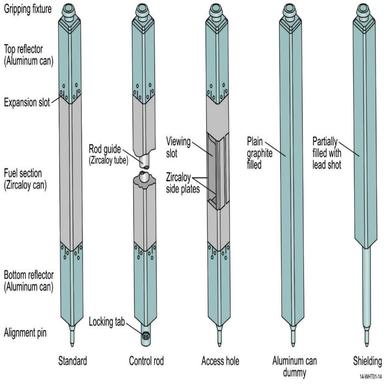
Typical TREAT Facility Assemblies.